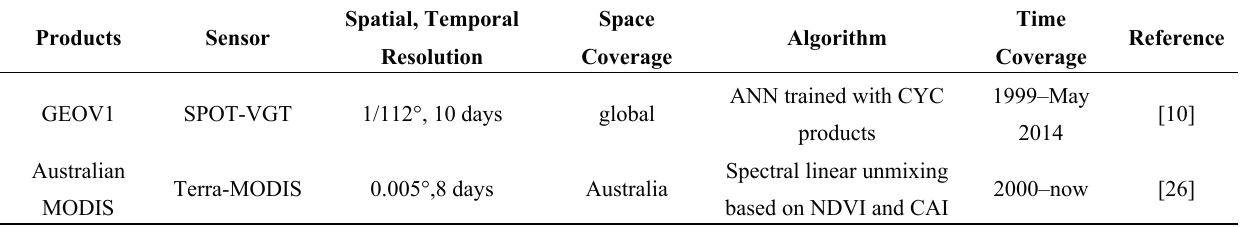
Table 1. Characteristics of the three remote sensing FVC products under